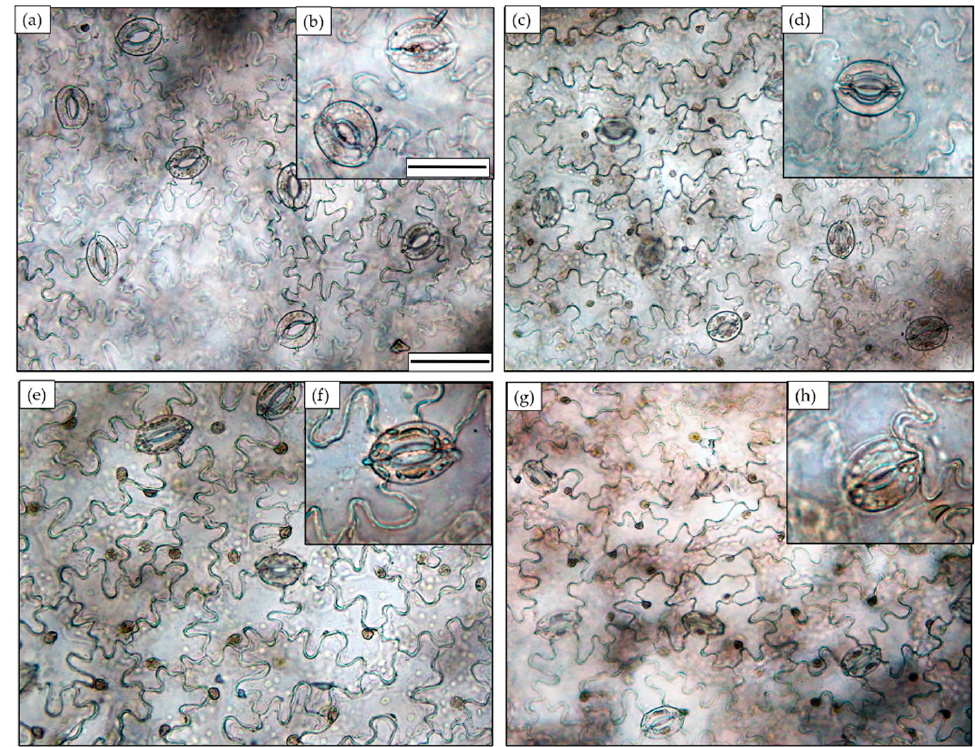
Figure 3. Lettuce stomatal morphology of LVG at 20 × ( a ) and 40 × ( b ), LVR at 20 × ( c ) and 40 × ( d ), HVG at 20 × ( e ) and 40 × ( f ), HVR at 20 × ( g ) and 40 × ( h ). See Section 2.3 for further details. Images and related details are at the same magnification in the different treatments; bars = 20 microns. Table 1. Effect of VPD (LV and HV) on stomatal traits of green (G) and red (R) plants: stomatal frequency (SF), stomatal size (SS) and stomatal index (SI) are shown. Mean values (n = 9) ± standard errors are shown. Different letters correspond to significantly different values, according to Tukey’s HSD ( p ≤ 0.05).